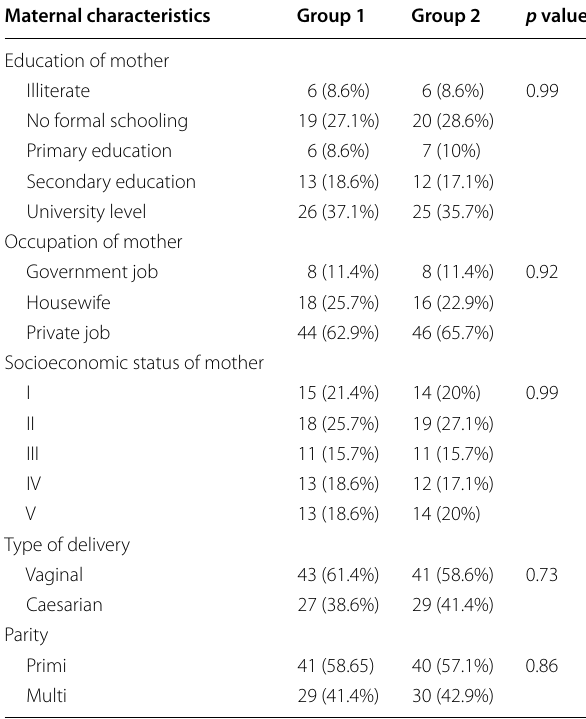
Table 1 Comparison of socio-demographic and obstetric characteristics of mother between two groups Maternal characteristics